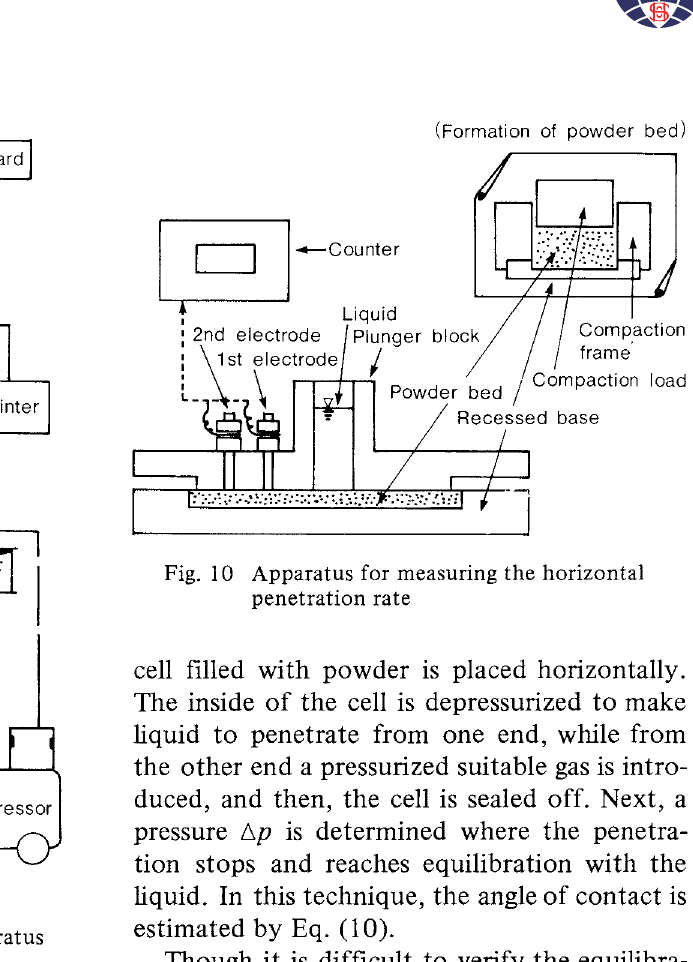
Fig. 9 Schematic diagram of the testing apparatus